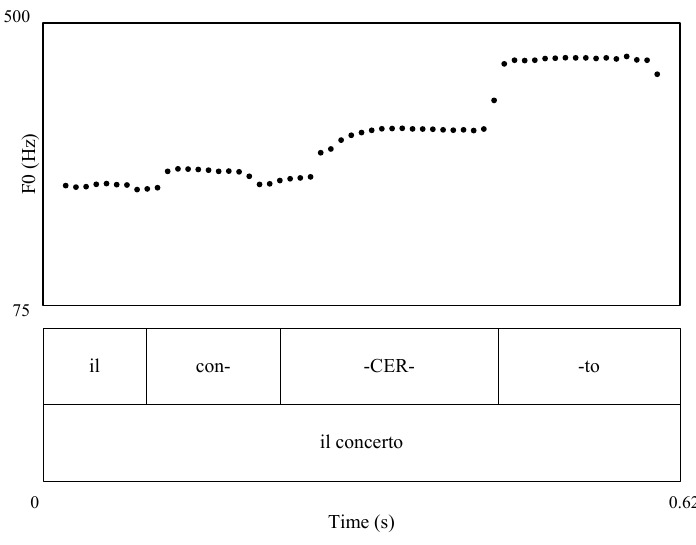
Figure 9. High rising contour for requesting completion (‘the concert…?’), produced by Ada in Extract (13). Repeats requesting completion do sometimes exhibit syntactic incompleteness (e.g. mi sono dimenticata di ‘I forgot to…?’), which provides a further cue to their function. Also, it is possible to find cases in the larger Italian corpus in which the repeat is followed by an in situ wh word (e.g. una che ‘a what?’), which functions as a placeholder for the material to be filled in. This latter format is the main way in which requests for completion are implemented in English (Schegloff et al. 1977:368), but appears to play only a marginal role in